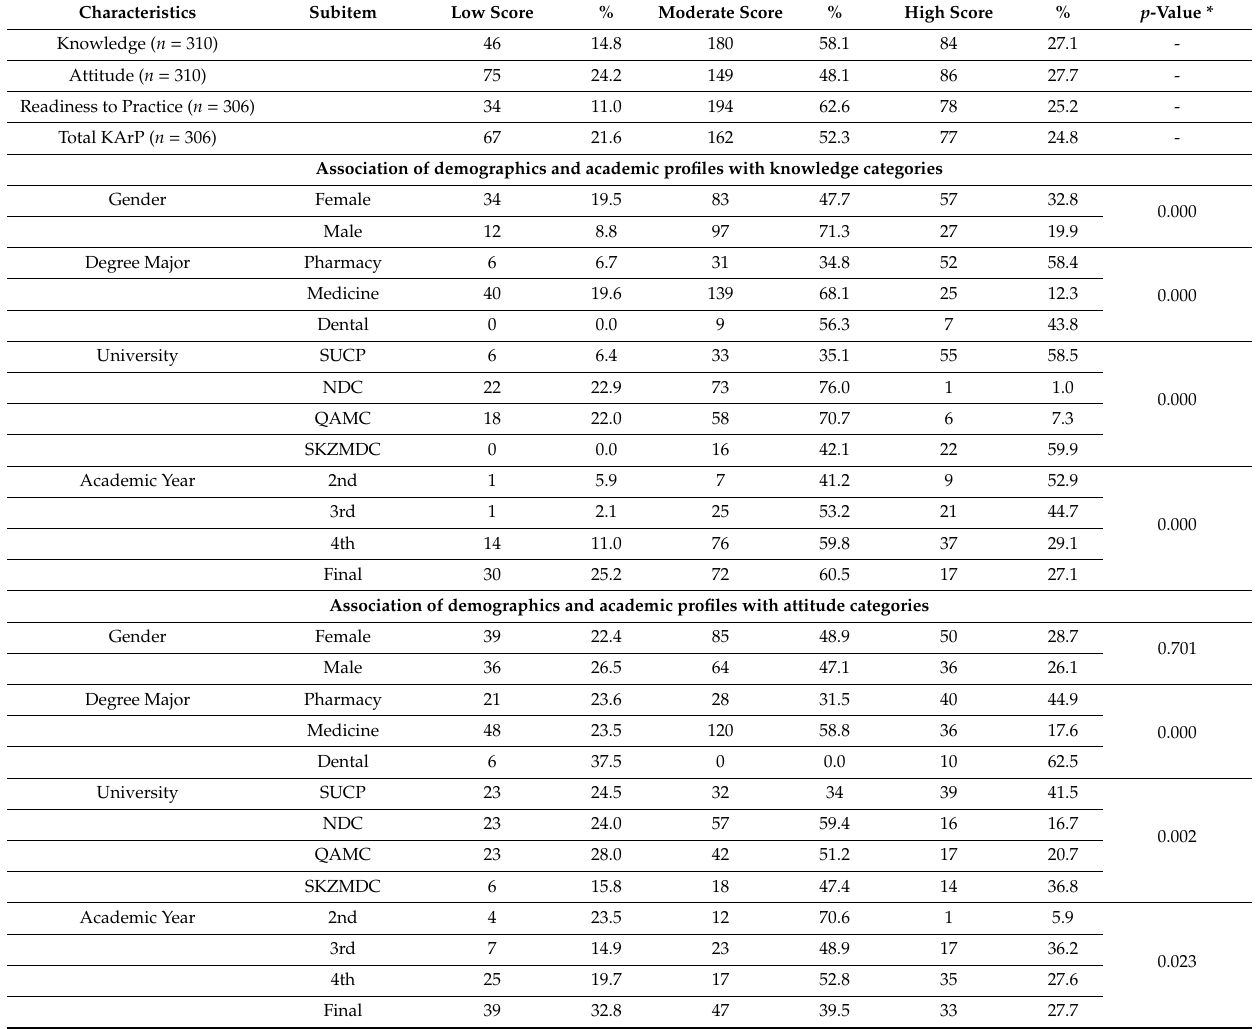
Table 3. Demographic and academic profile associations with di ff erent K, A, rP, and KArP